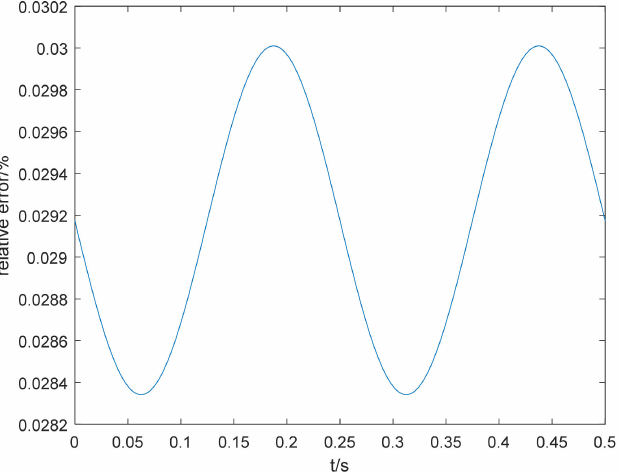
Figure 6. Relative error of the non-time-varying stiffness k ∗